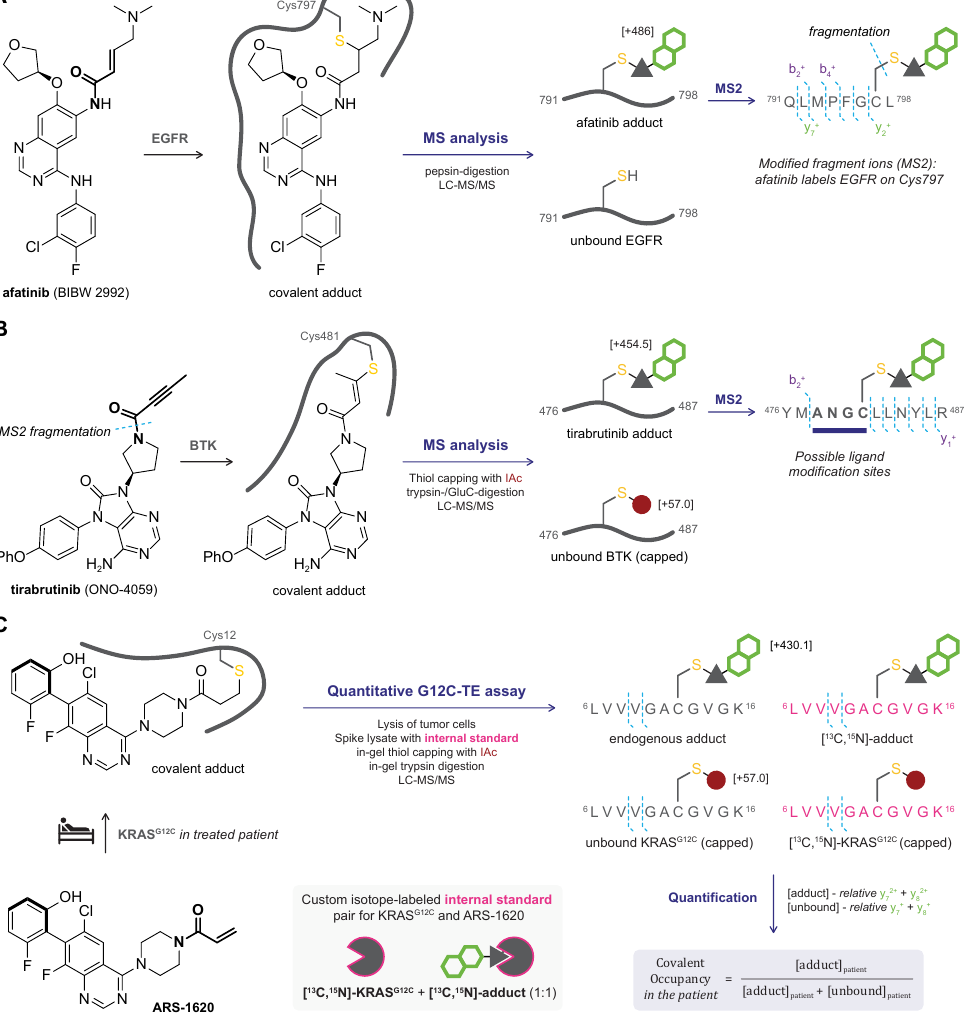
Figure 5. LC-MS/MS analysis of covalent protein–drug adducts. ( A ) Identification of the covalently targeted amino acid by afatinib (BIBW 2992) in purified kinase domain EGFR T790M/L858R [14]. ( B ) Identification of covalently modified amino acids in recombinant BTK kinase domain by BTK inhibitor tirabrutinib (ONO-4059) [88]. MS2 detection only showed unmodified fragment ions and ligand fragmentation of unbound tirabrutinib. ( C ) Internally controlled quantitative KRAS G12C Target Engagement (G12C-TE) assay illustrated with KRAS G12C inhibitor ARS-1620 [100]. Lysates originating from clinical tumor biopsies are spiked with an internal standard: recombinant stable isotope-labeled KRAS G12C (1–169) internal standard consisting of a 1:1 mixture of